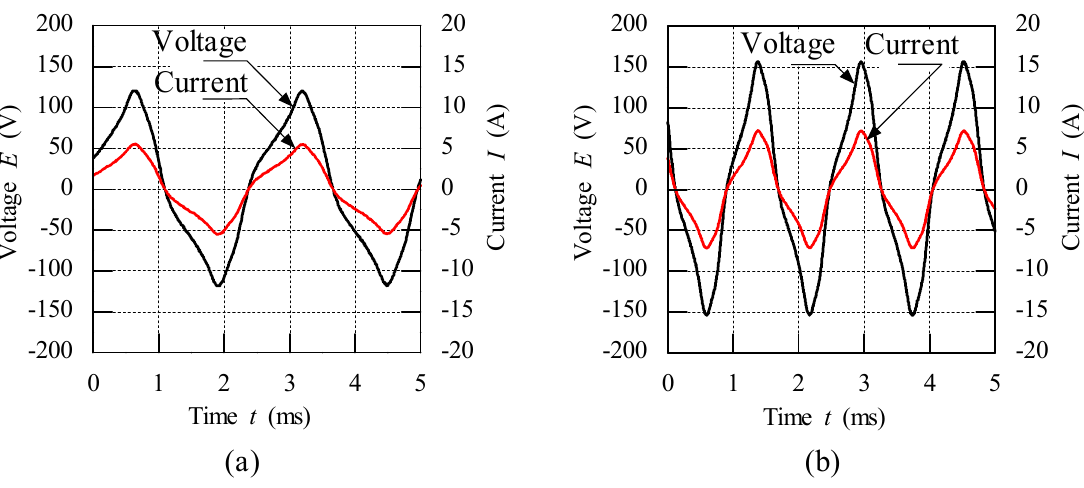
Figure 5. Electrical characteristics for load resistance of 20 Ω . ( a ) TVR 20% at load resistance 20 Ω ; ( b ) TVR 80% at load resistance 20 Ω